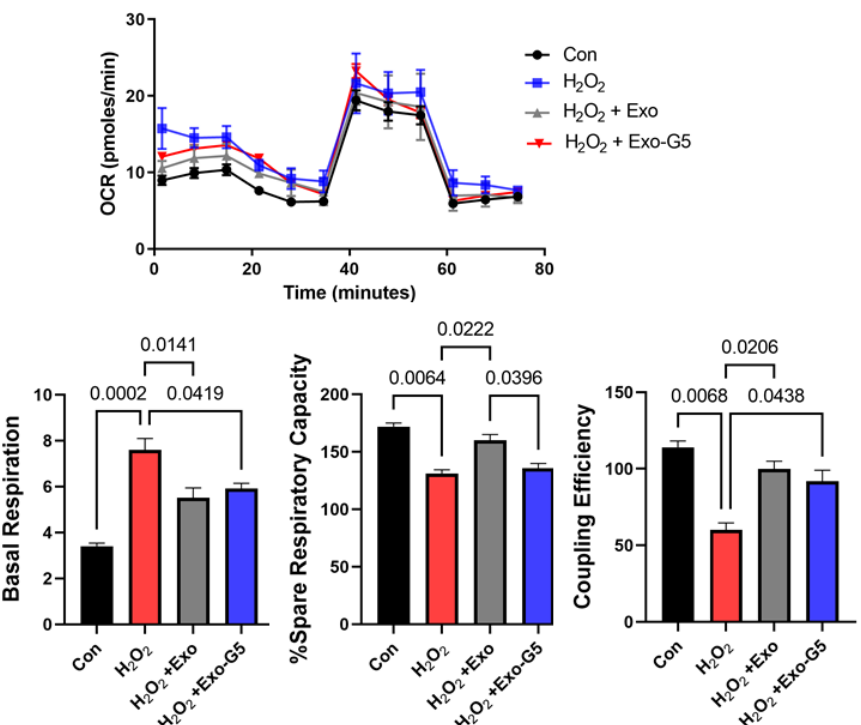
Figure 2. HDF cells were seeded in a Seahorse XFp miniplate and treated with 100 µ M H 2 O 2 for 1 h, followed by medium change and treatment with hASC exosomes (Exo) or exosomes depleted of GAS5 (Exo-G5) for 18 h. A Mito Stress Test Assay was performed according to the manufacturer’s instructions and repeated three times. The readings were normalized to the protein content of each well. Seahorse Wave software was used for analysis of oxygen consumption rate (OCR), basal respiration, percent spare respiratory capacity and coupling efficiency ( n = 3). Statistical analysis was performed by one-way ANOVA and significant p -values (<0.05) are indicated on the graph.